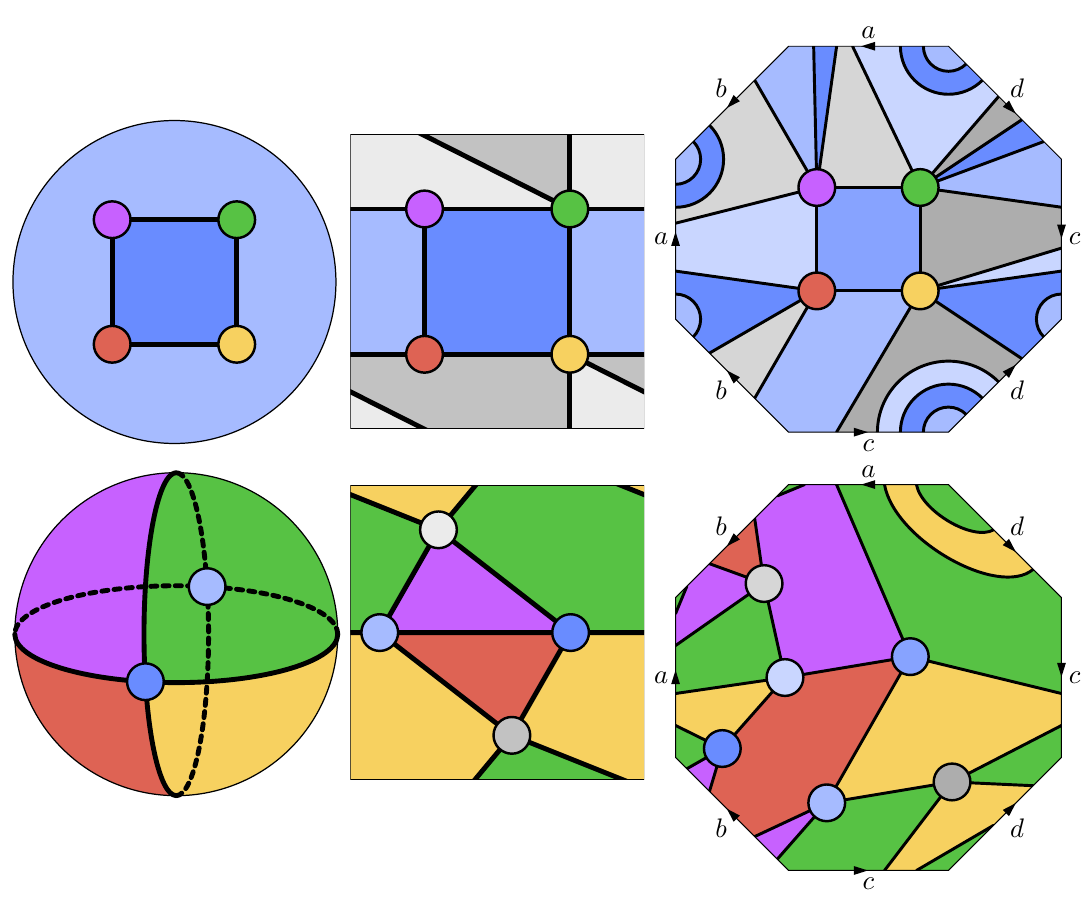
Figure 9 . Example graphs at genus g = 0 ; 1 ; 2 (top) with their duals (bottom). In the top row we have four vertices (the BPS operators) and 2 g + 2 faces (the squares). In the bottom row we have four faces (the BPS operators) and 2 g + 2 quartic vertices (the squares).